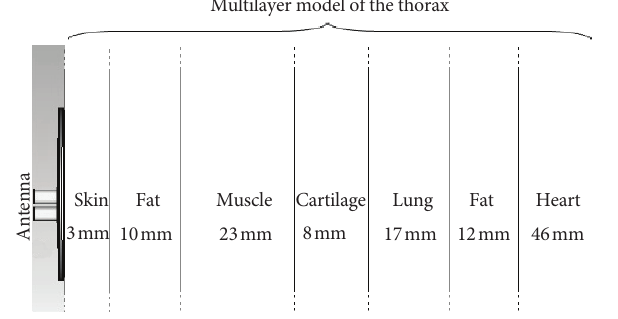
F 4: Twin antenna in front of a multilayer model of the